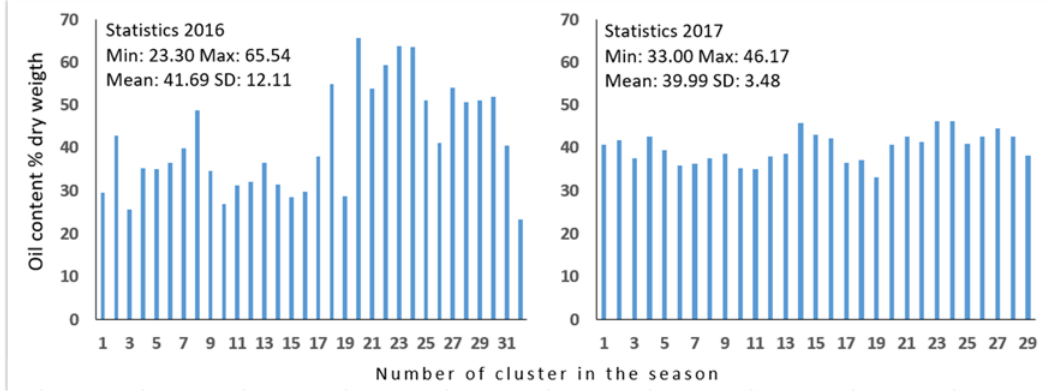
Figure 6. Bar graphics of OC (average of two repetitions) and statistics of the clusters in seasons 2016 and 2017.